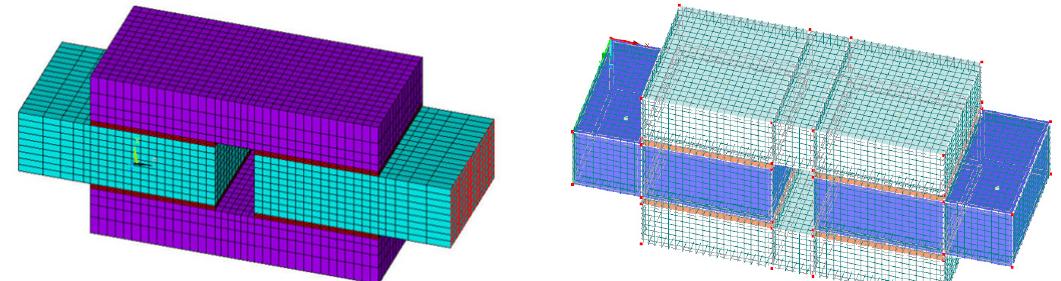
Fig. 7 Numerical model of the shear-glass connection test specimen, on the left – ANSYS 11, on the right – RFEM 5.05.